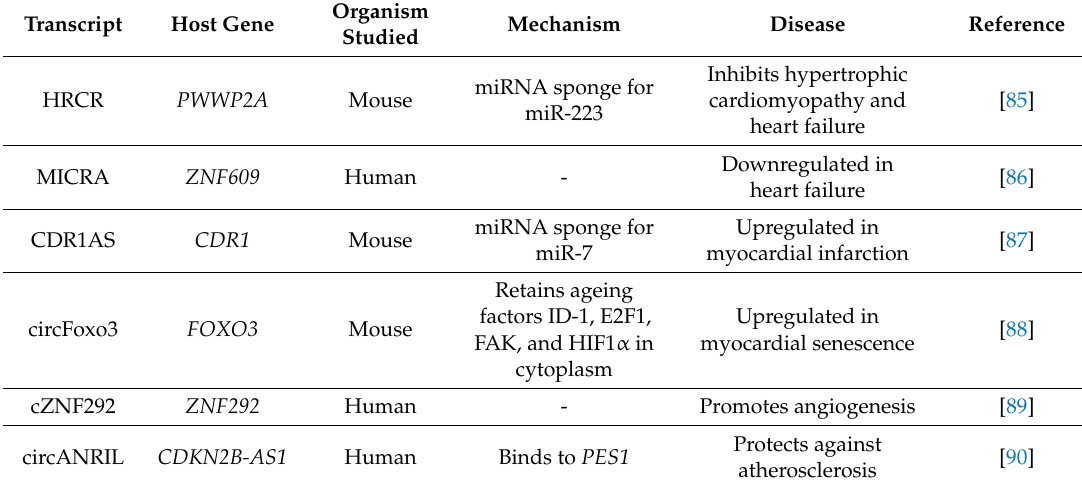
Table 3. List of clinically relevant circRNA in cardiovascular